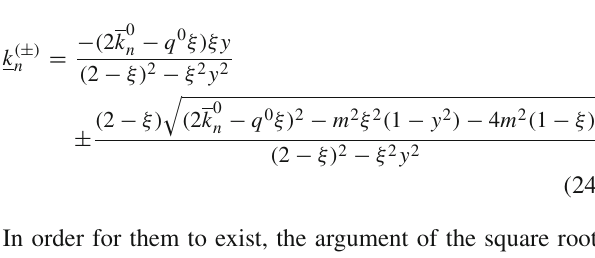
Eq. (23), and since they are smooth function of both ξ and y in their allowed range (that includes the ξ = 0 point), we infer by continuity that they satisfy Eq.